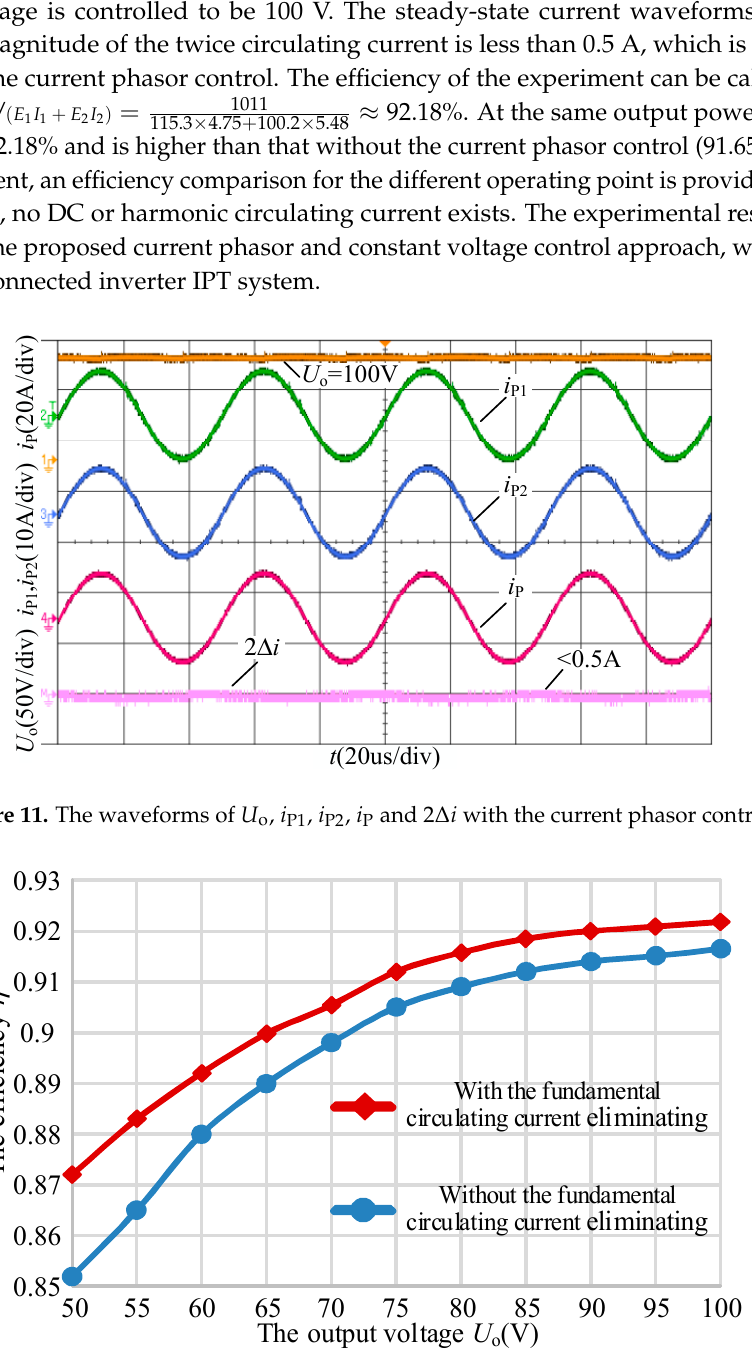
Figure 12. An efficiency comparison for different operating point (at U o = 50–100 V).